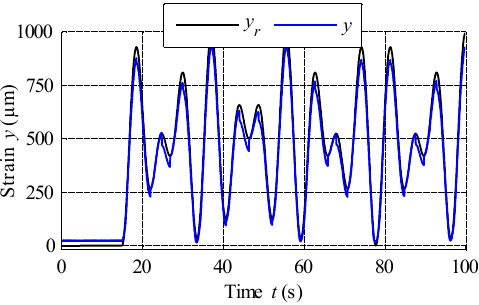
Figure 17. Open-loop control with compensator placed in series in the control loop.